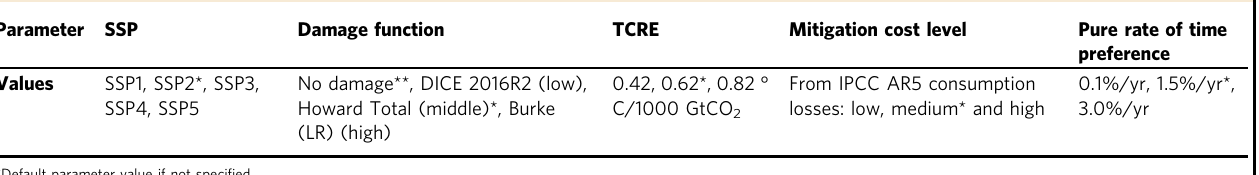
Table 1 Values for the main parameters of the